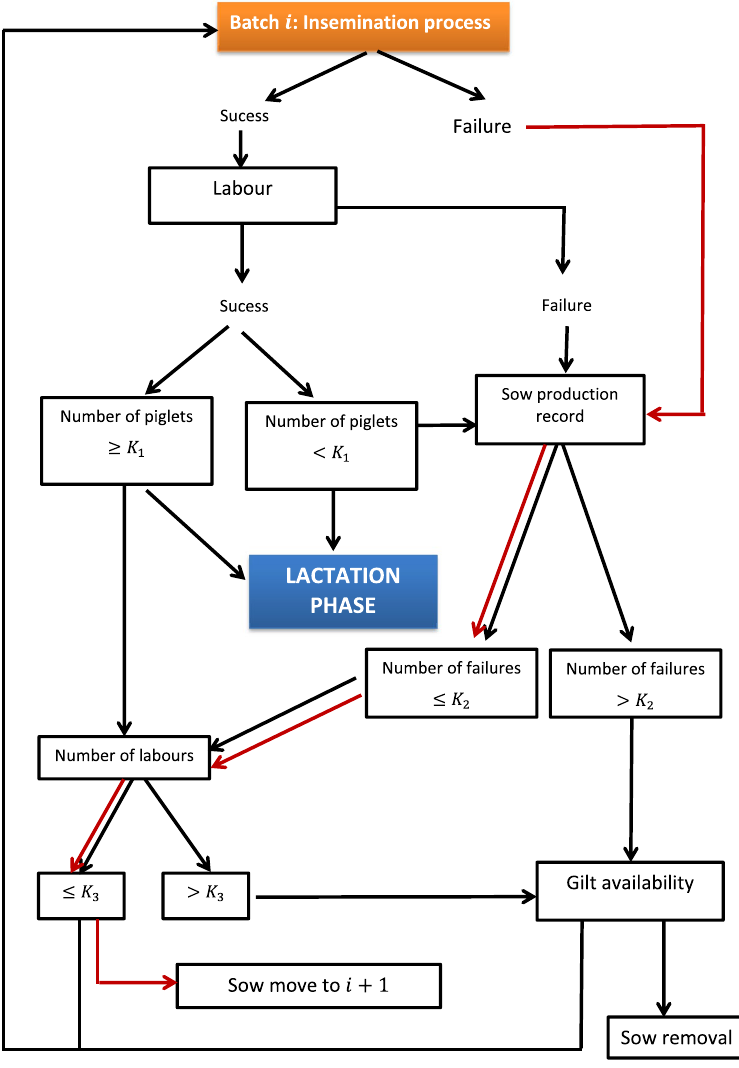
Figure 3. Functioning diagram of the reproductive phase in a pig